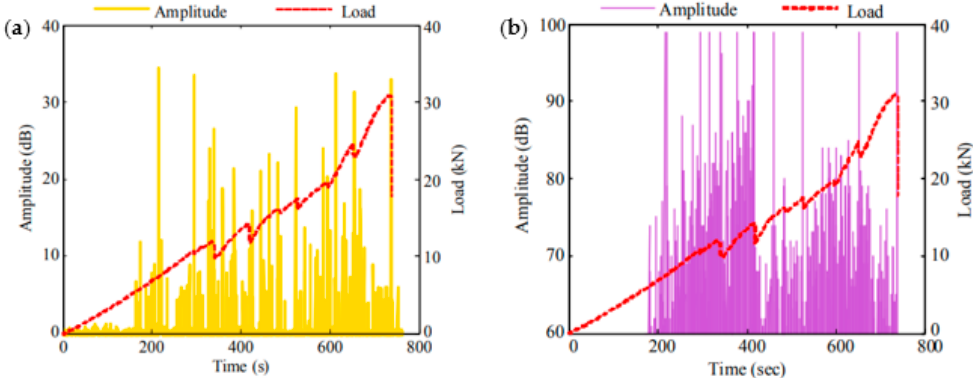
Figure 9. Amplitude verses time measured by the: ( a ) phase-shifted FBG sensor and; ( b ) piezoelectric sensor [173].